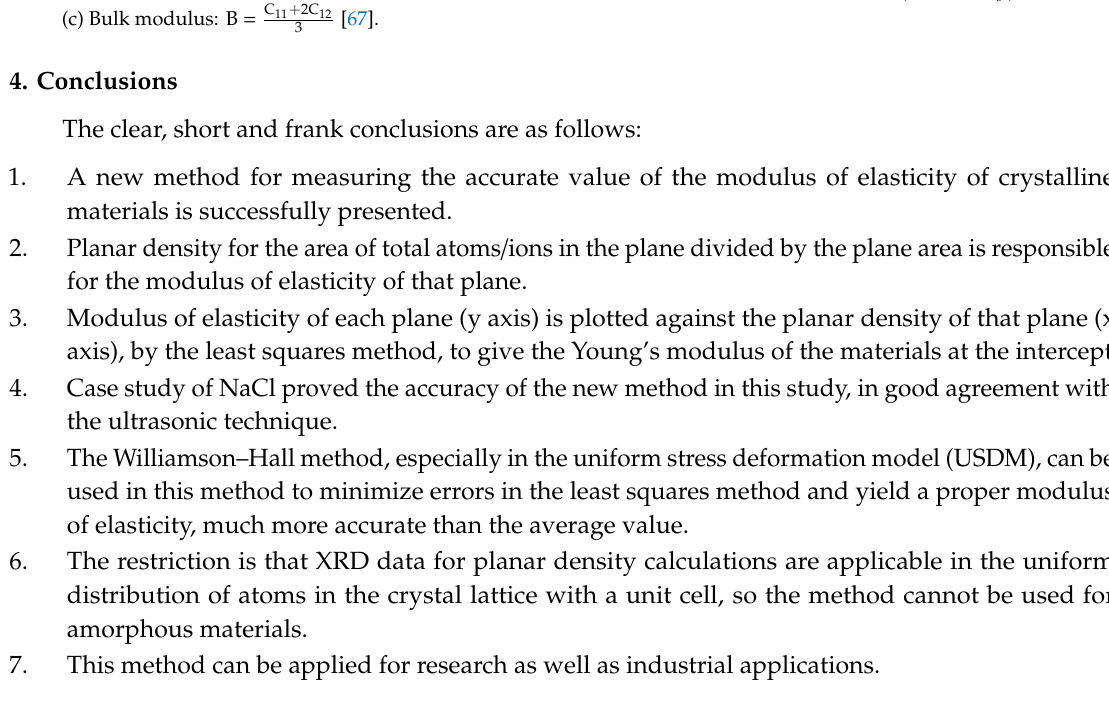
Figure S1: Geometry and the situation of involved atoms in di ff racted planes (d) (311), (e) (222), (f) (400), (g) (331), (h) (420), (i) (422) and (j) (511) related to the